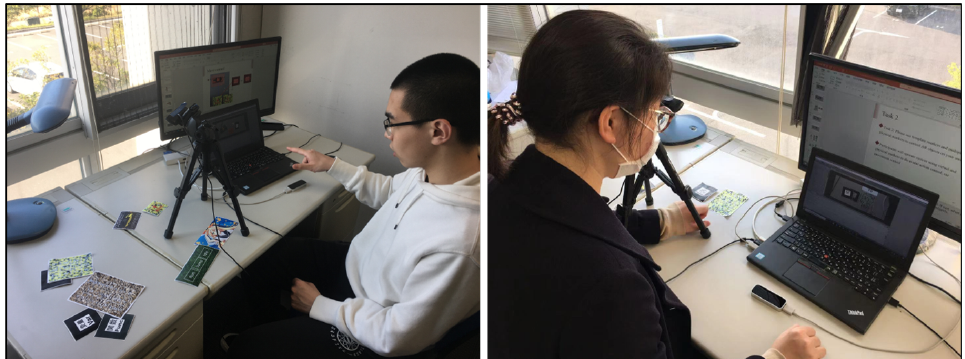
Figure 13. The experimenters performed tasks by themselves after